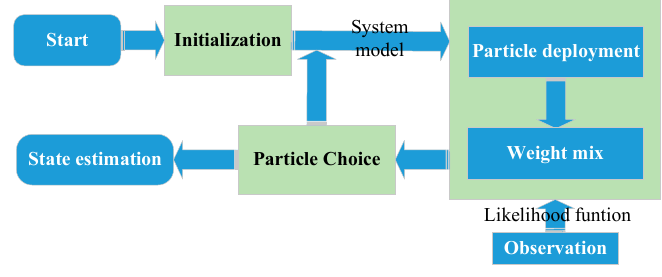
Figure 7. TMCF system block diagram.